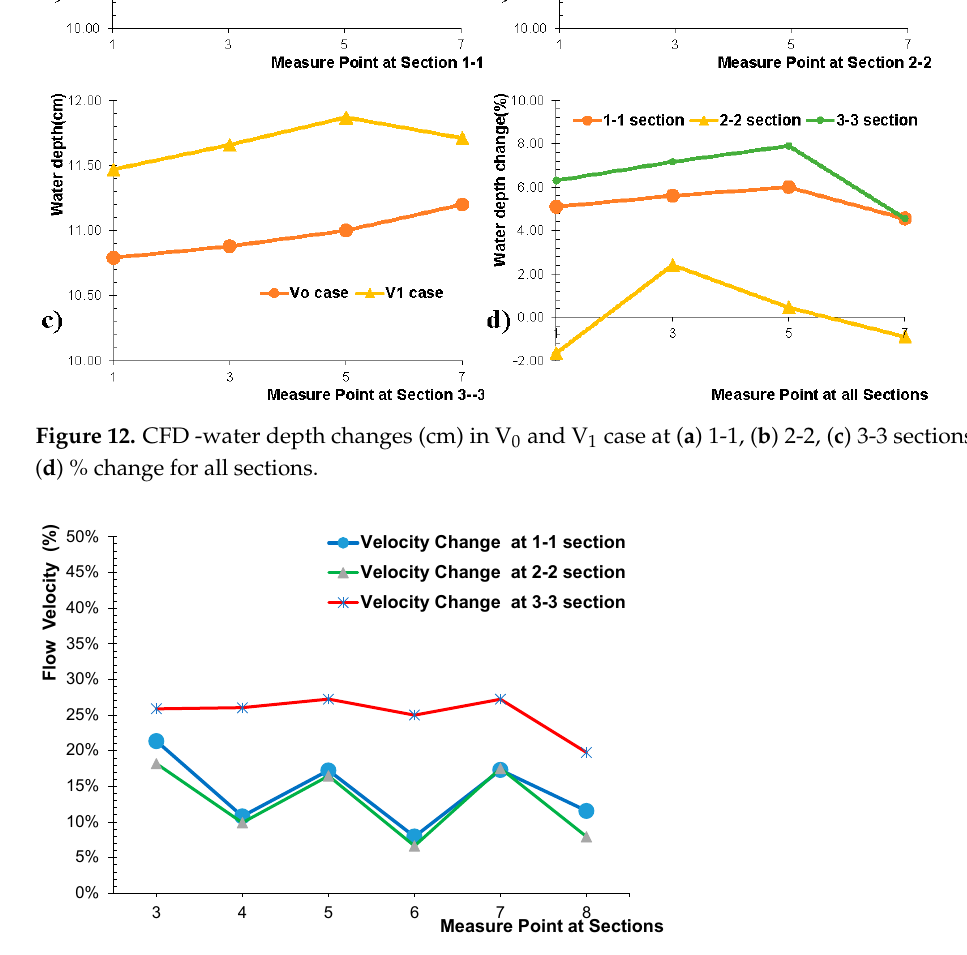
Figure 13. Flow velocity change according to 1-1, 2-2 and 3-3 sections for behind the submerged vane.